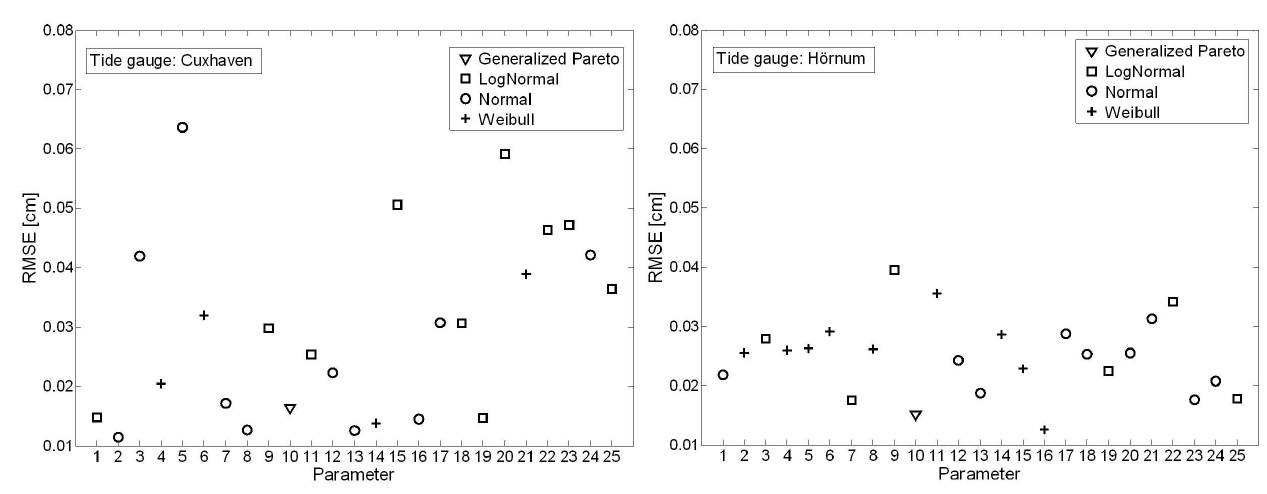
Fig. 10. RMSE values calculated after fitting distribution functions to the 25 parameter time series of the tide gauges of Cuxhaven (left) and H¨ornum (right) (only the values for the distribution functions with the smallest RMSEs are shown). Table 2. Filter functions considered for the present study to avoid inconsistencies in the simulation